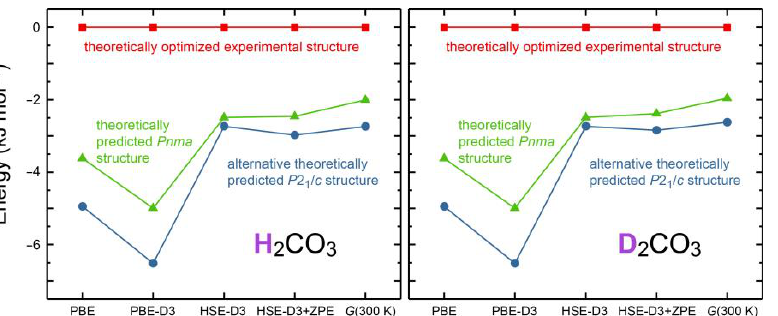
Figure A1. Relative energies of various DFT-derived polymorphs of regular ( left ) and deuterated ( right ) carbonic acid at 2 GPa. PBE = Perdew – Burke – Ernzerhof functional, D3 = Grimme D3 disper- sion correction, HSE = Heyd – Scuseria – Ernzerhof functional, ZPE = zero-point energy correction, G (300 K) = Gibbs energy at 300 K.